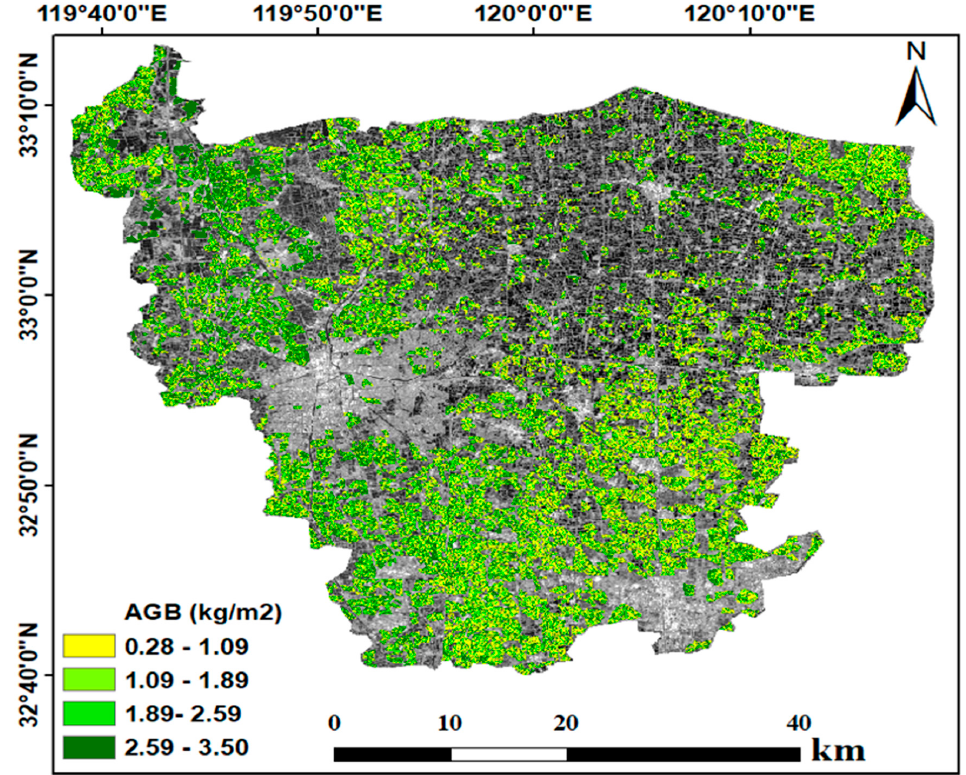
Figure 7. Spatial distribution of AGB estimated by MGPRS using SODVI as input. This map was created for August 10 using blended high-resolution Sentinel images. On this date, the growth stages of rice fields were generally between the beginning and end of panicle emergence.